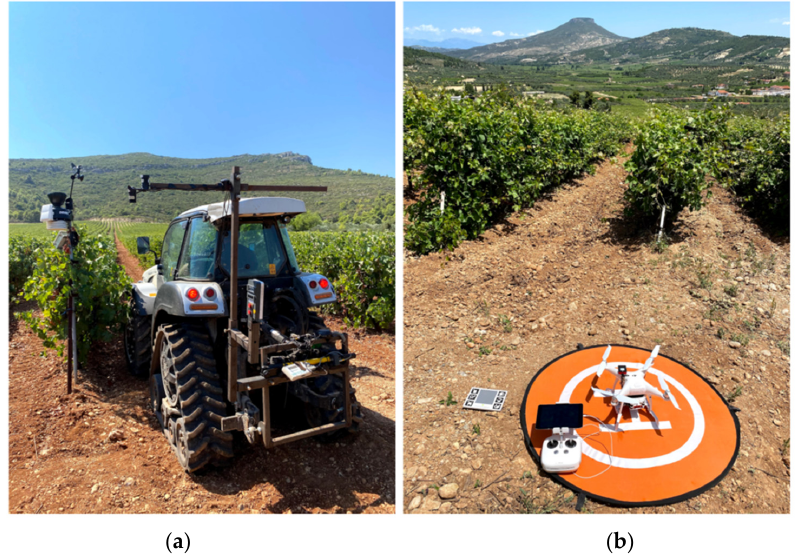
Figure 2. Grapevine canopy properties were estimated using ( a ) two vehicle-mounted crop reflectance sensors, ( b ) UAV-acquired data and Sentinel-2 archived imagery. Table 1. Grapevine seasonal EL growth stages of proximal and remote sensing data acquisition. Dates reported in Table 1 relative to both seasons (2019 and 2020).